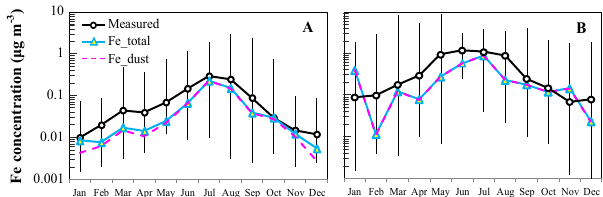
Figure 10. Seasonality of Fe concentrations attached to aerosols in surface air at Bermuda (32.2 ◦ N, 64.5 ◦ W) (a) and Barbados (13.2 ◦ N, 59.3 ◦ W) (b) on the western margin of the Atlantic Ocean. Modelled Fe concentrations are derived from all sources (Fe_total) and from mineral sources only (Fe_dust) as medians of all days of each month of 2005. Measured Fe concentrations are shown as the medians (circles) for 1988–1994 with the ranges between the 10th and 90th percentiles (error bars).